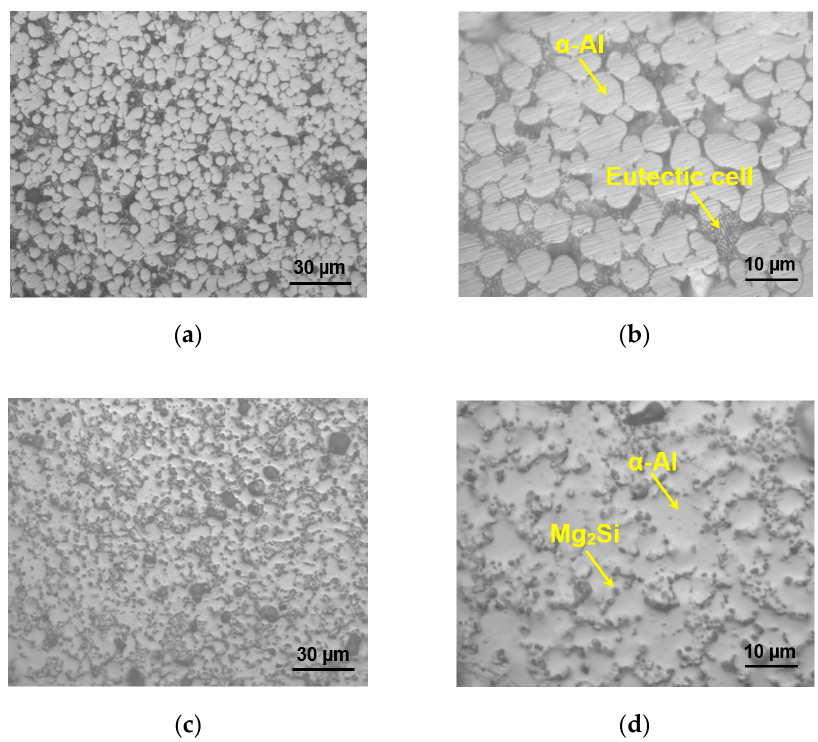
Figure 2. Typical optical microscope (OM) images showing the microstructures of as-cast Al alloy at ( a ) lower and ( b ) higher magnifications and heat-treated Al alloy at ( c ) lower and ( d ) higher magnifications.